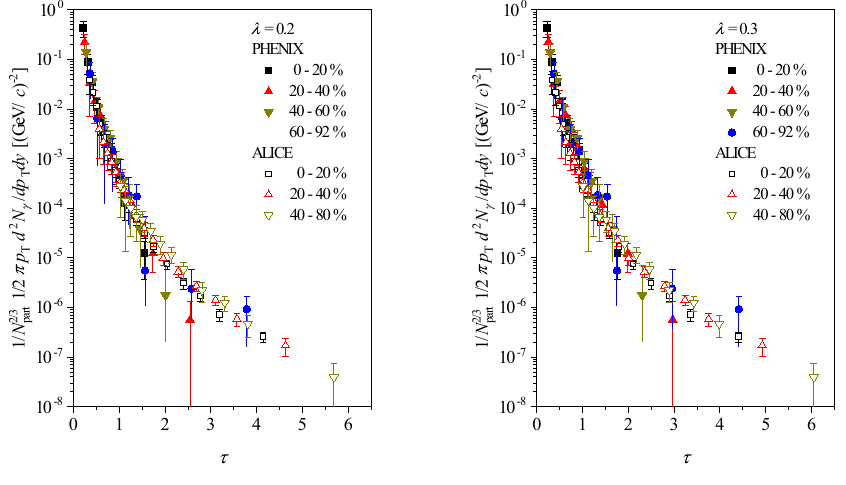
Figure 7. Illustration of geometrical scaling of the (cid:13) yields in heavy ion collisions for di (cid:11) erent centrality classes for PHENIX AuAu data at 200 GeV [20] and Alice data at 2.76 TeV [22]. Left panel: (cid:21) = 0 : 2, right panel (cid:21) = 0 : 3. Lower error bars without end caps have been arbitrarily shortened for better